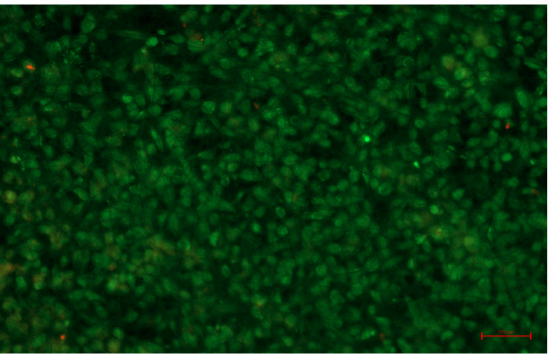
Figure 7. SHEE cell viability on the e-spun hierarchical film. The scale bar is 100 µ